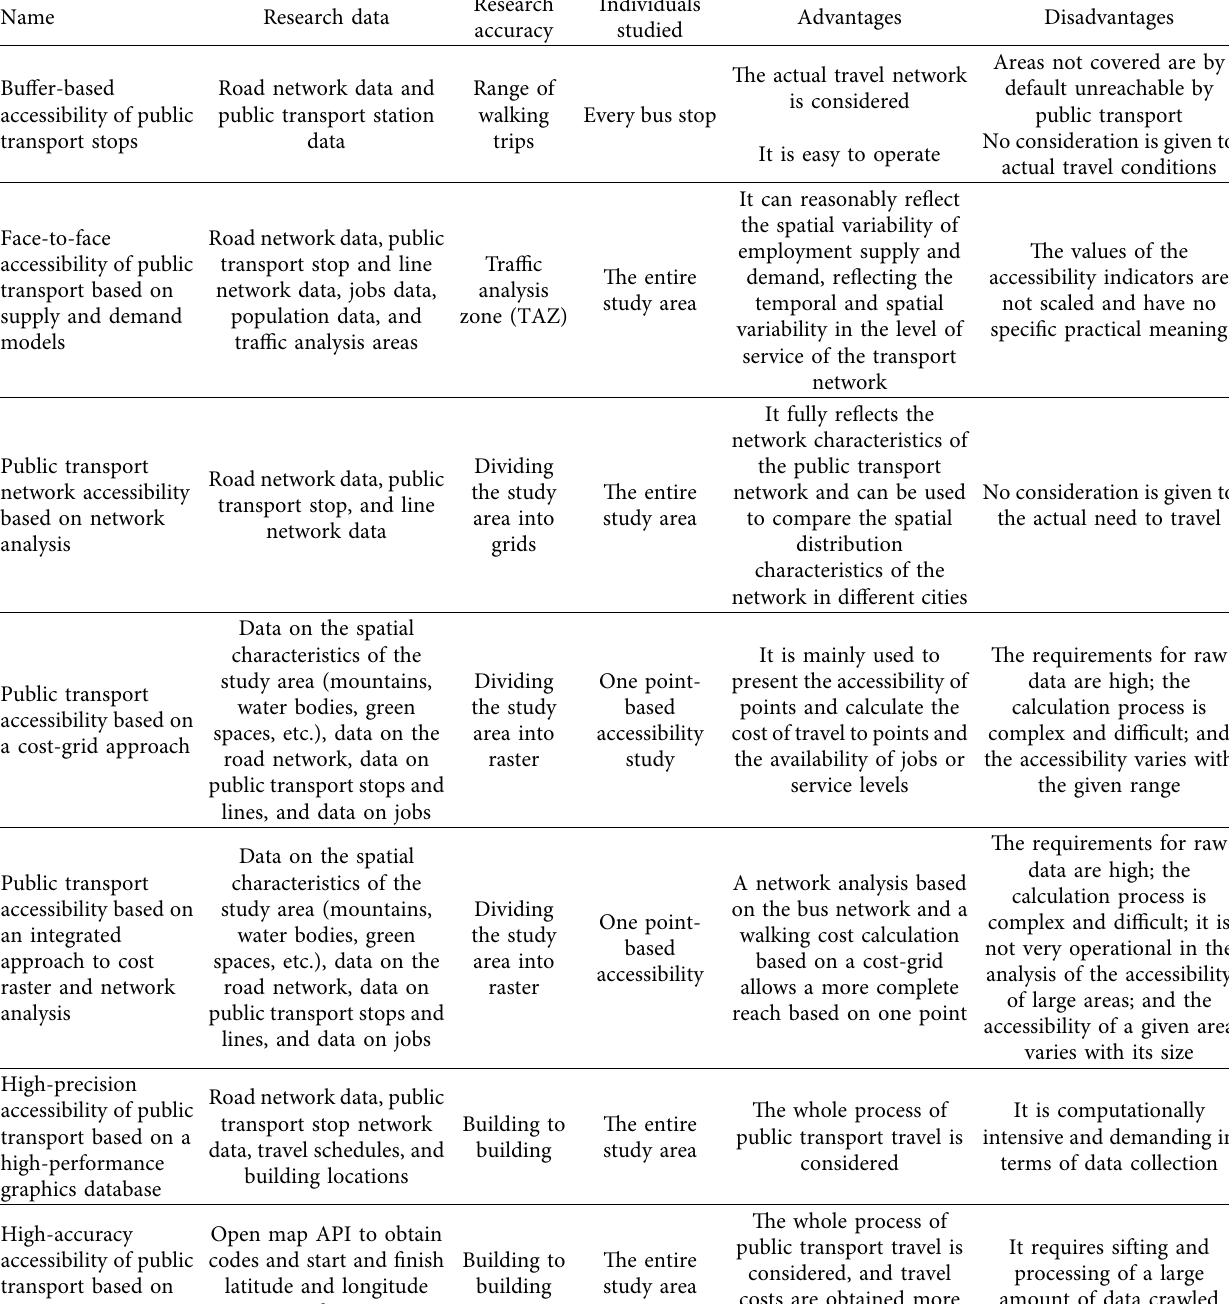
Table 1: Summary of public transport accessibility